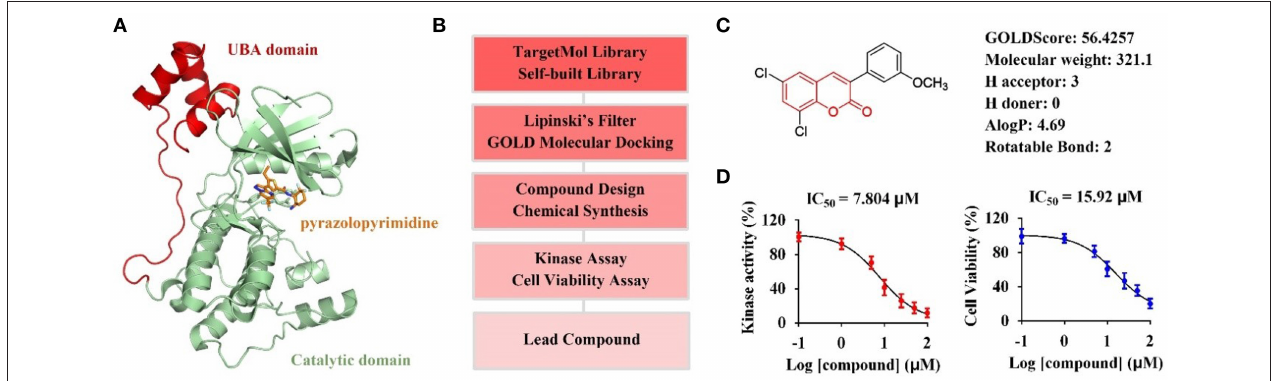
FIGURE 1 | Computer-aided virtual screening of potential MARK4 inhibitors. (A) Crystal structure of MARK4 catalytic domain in complex with pyrazolopyrimidine inhibitor (PDB ID: 5ES1). (B) Workflow for computer-aided screening of MARK4 inhibitor. (C) Selected hit compound with coumarin moiety after Lipinski’s filtering